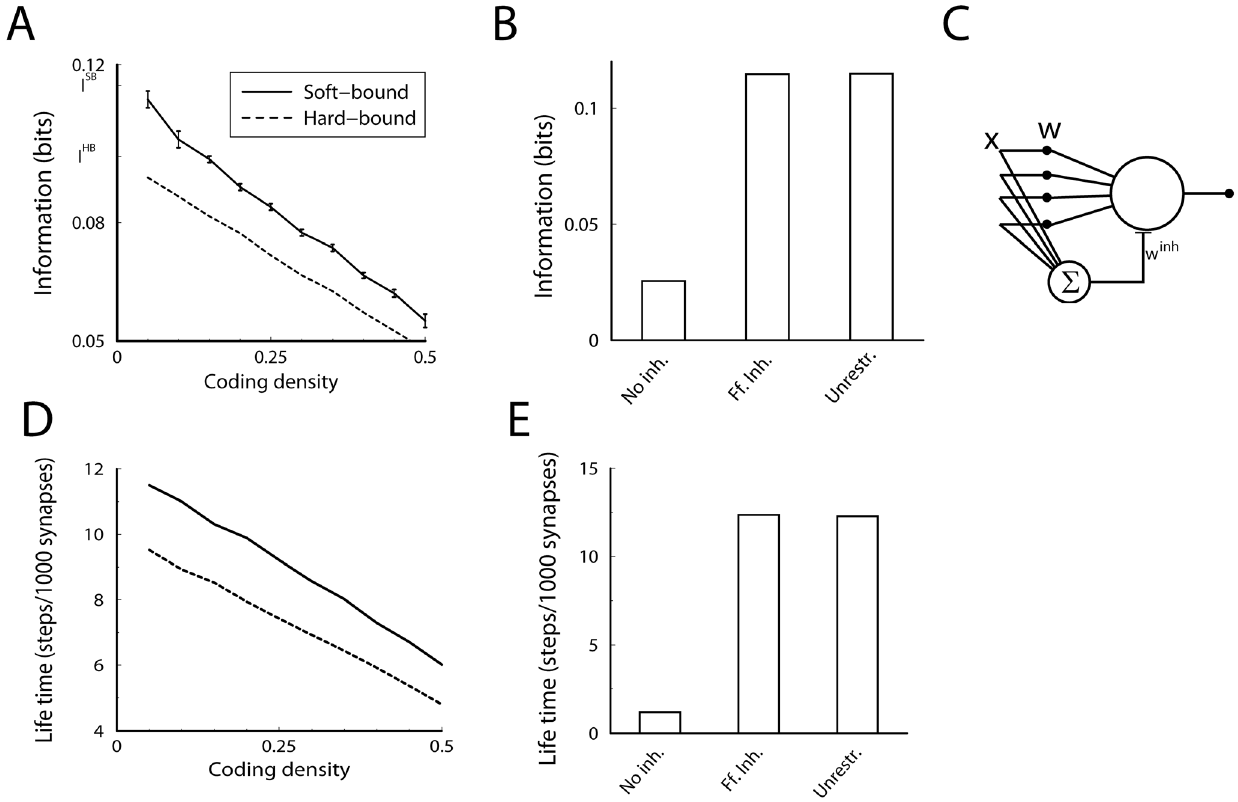
Figure 4. Effect of coding density and inhibition on performance. A. The synaptic information capacity versus the coding density for soft- bound (solid line) and hard-bound (dashed line) plasticity, when taking 0s and 1s as inputs. When coding density is 1/2, the capacity is approximately half of what it is when using + 1 as inputs. However, low coding density improves the synaptic information capacity and in the limit of very sparse codes (utmost left in the graph) the capacity reaches that of Figure 3A. B. Effect of feed-forward inhibition on capacity under soft-bound plasticity. Using excitatory synapses ( w i § 0 ) without inhibition, capacity is strongly reduced (‘No inhibition’). Adding feed-forward inhibition maximizes information capacity (‘Feedforward inhibition’). Equivalently, high capacity is achieved when the plasticity rules are defined such as to allow for negative weights (‘Unrestricted’). C. Possible circuit to implement feed-forward inhibition. D + E. Effects of coding density and inhibition on the information (panel A + B) on the information are mirrored by the effects on the memory lifetime.